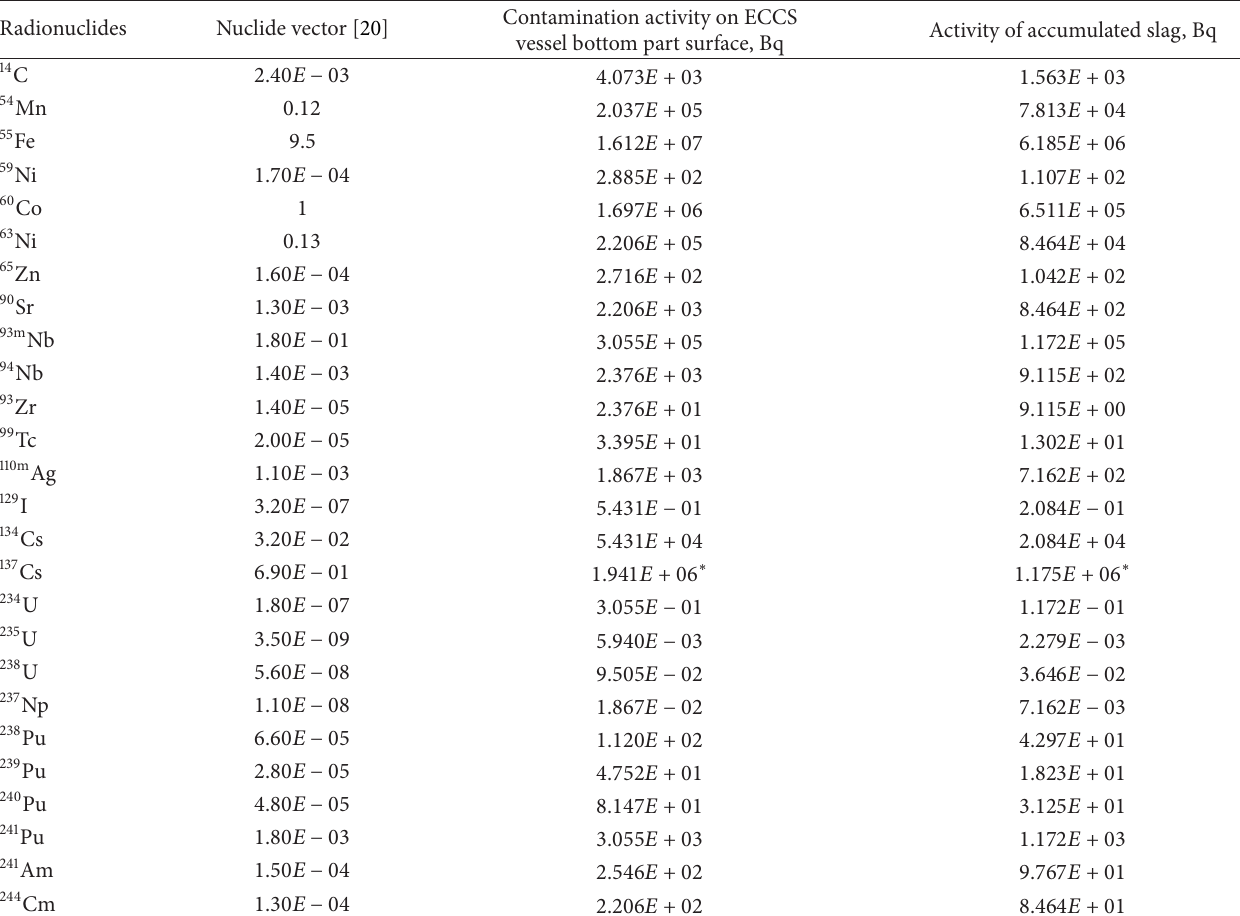
Table 3: Source term for ECCS vessel bottom part and accumulated